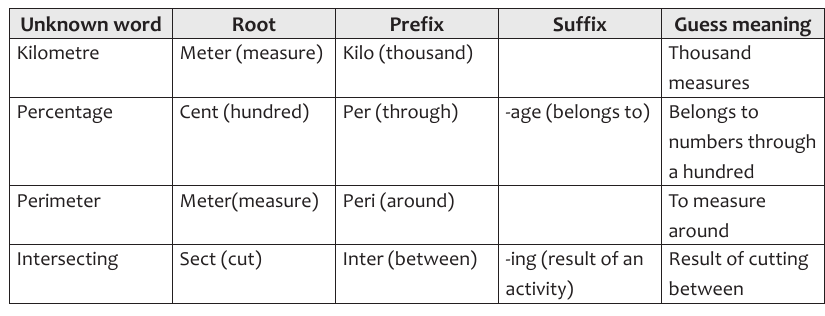
Table 2: Root Words, Prefixes and Suffixes